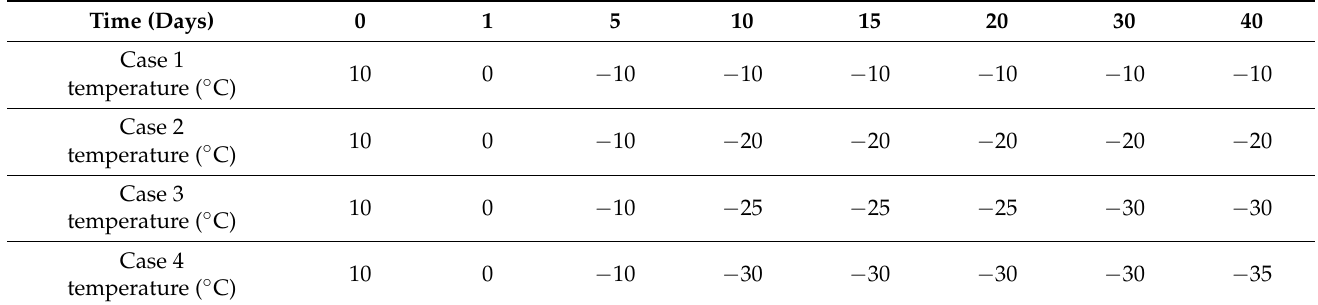
Table 5. Cooling schedule for different initial temperatures.